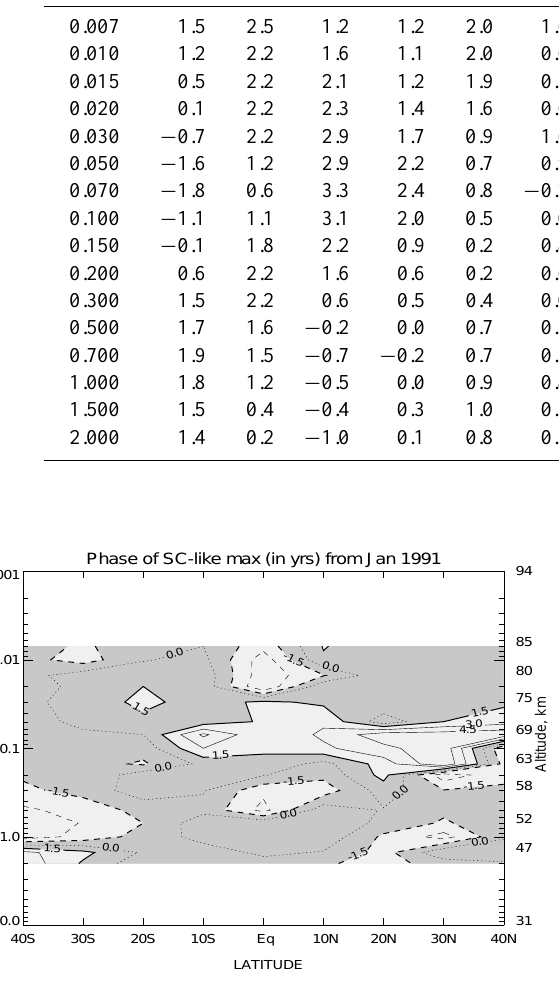
Fig. 15. Contour plot of the phase of the SC-like maximum (in years) as referenced to January 1991. The shaded regions have a phase maximum within ± 1.5yrs of that date. Contour interval is 1.5 years. Negative values are dashed and the zero contour is